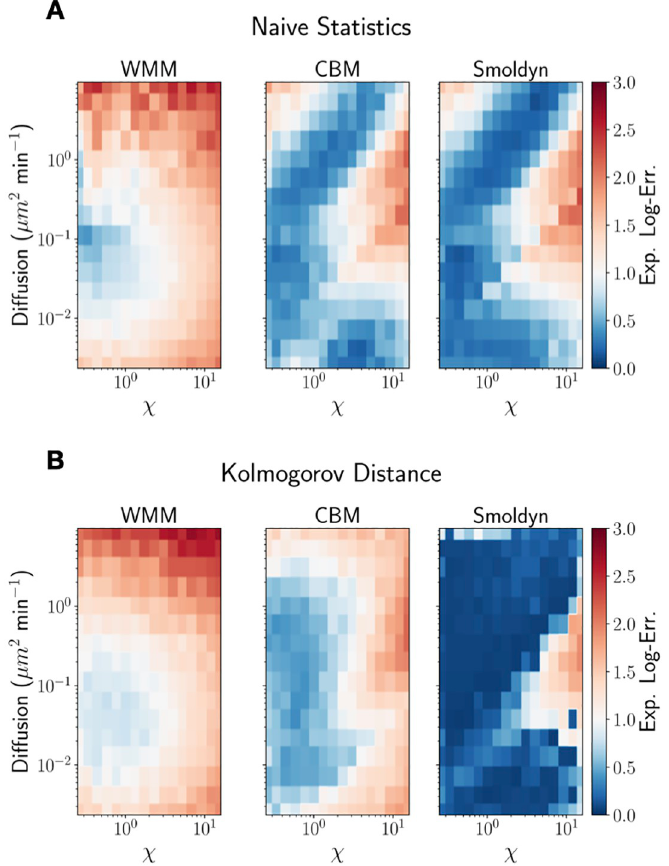
Fig 4. Heatmaps of expected log-error for different combinations of the diffusion coefficient (D, y-axes) and reactivity coefficient ( χ , x-axes). The results presented in (A) are based on summary statistics while those presented in (B) are based on the Kolmogorov distance. The title of each heatmap corresponds to which model fidelity was used. The CBM performs almost as well as Smoldyn when using summary statistics. When using the Kolmogorov distance, Smoldyn outperforms the two other